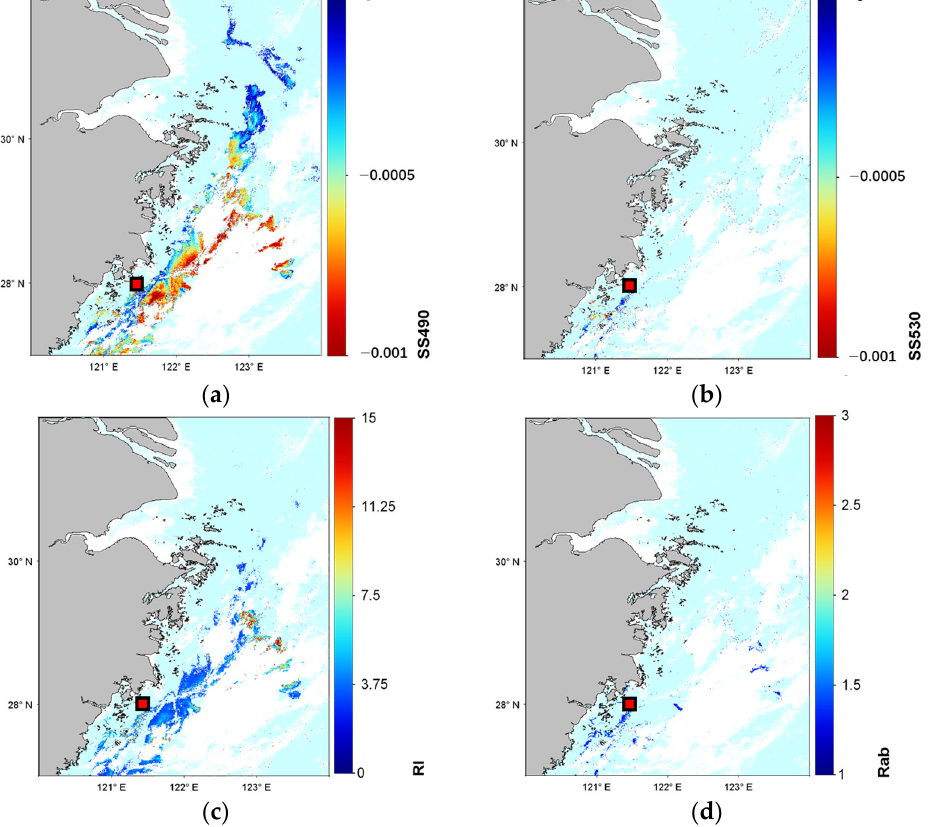
Figure 7. Bloom extraction maps using the methods: ( a ) SS(490) < 0; ( b ) SS(530) < 0; ( c ) R ab > 1.25; and ( d ) RI > 2.8 from the SGLI image on 29 April 2020. Note that all the bloom pixels were assessed using the criteria of R rs ( 565 ) < 0.014 sr − 1